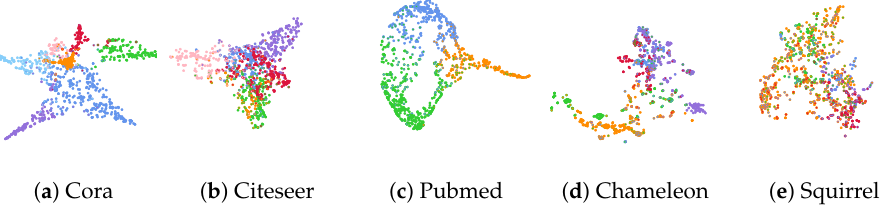
Figure 2. We applied our model to several datasets and obtained t-SNE visualization. The class label assigned by the ground truth is represented by the outline color, while the class label predicted by the model is represented by the fill